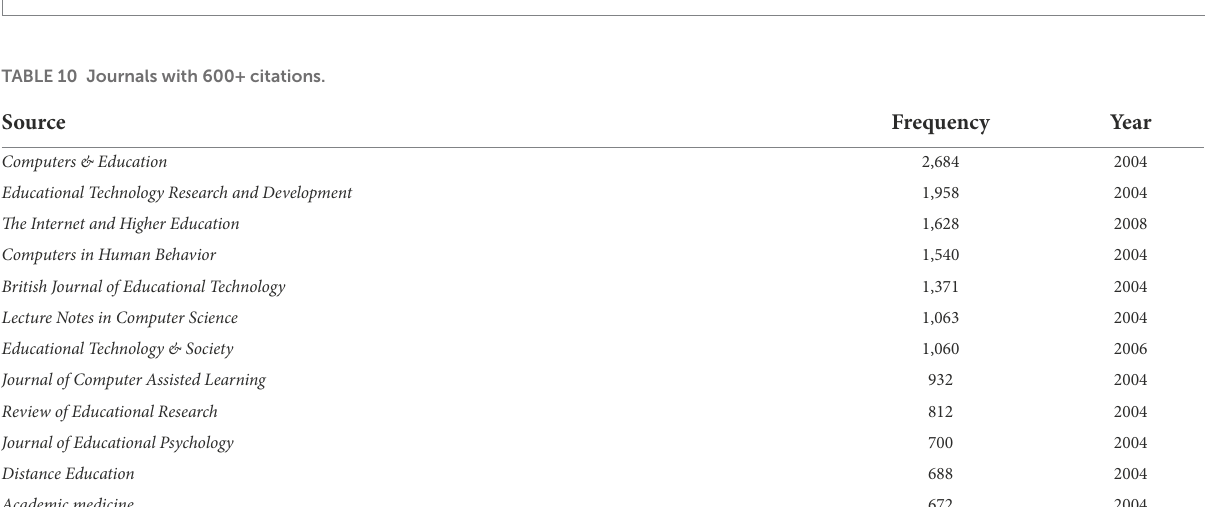
FIGURE 8 Cited journal network.